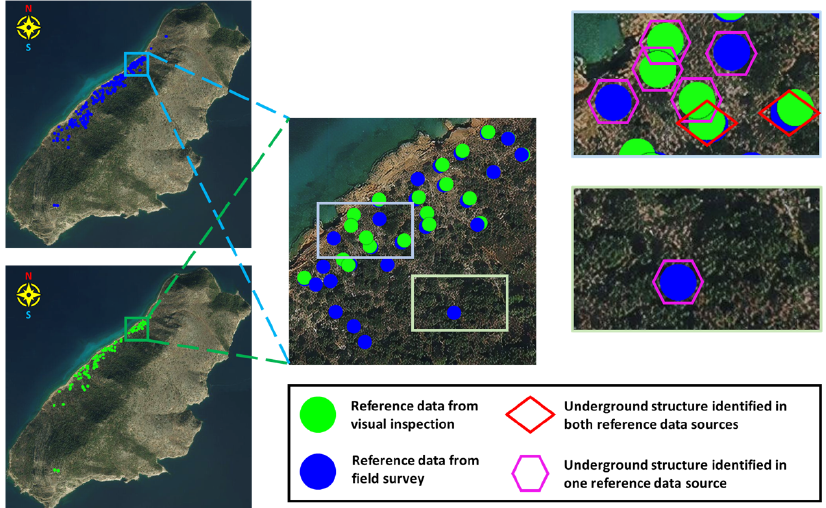
Figure 23. Illustration of reference data generated through visual inspection of image and LiDAR data (in green) as well as fi eld survey (in blue).